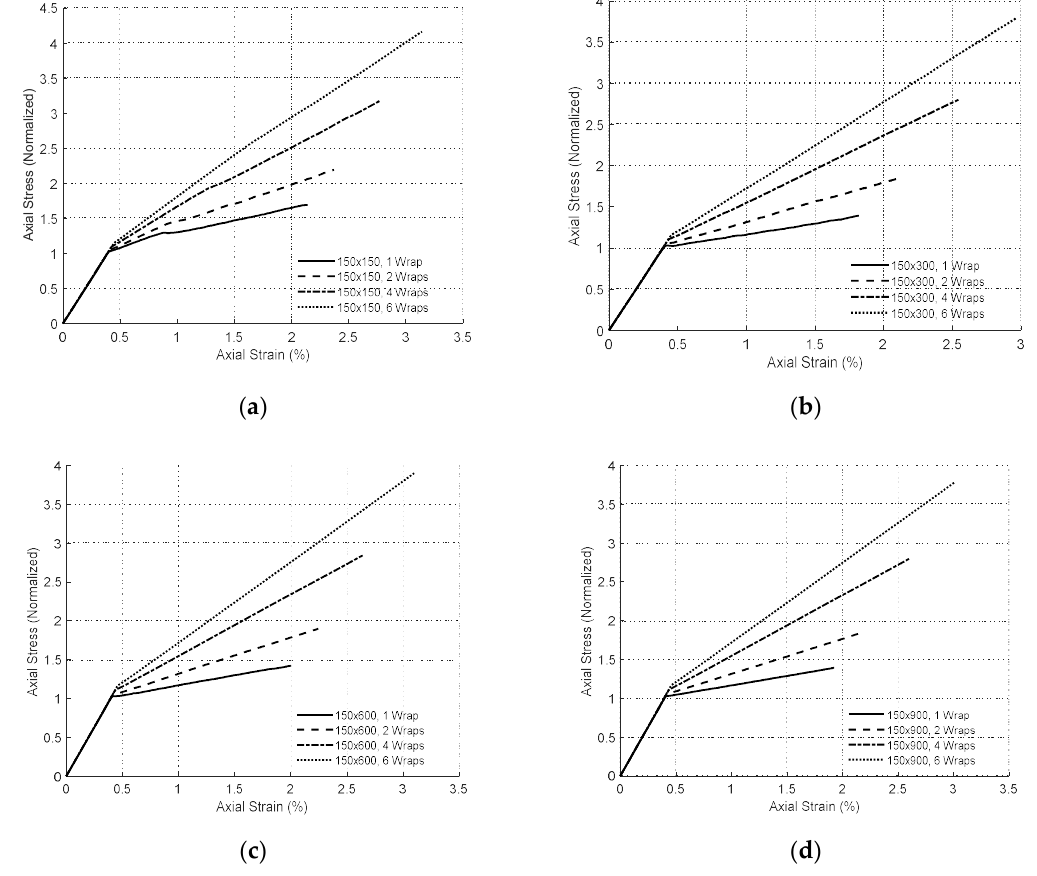
Figure 4. Effect of the number of wraps on the axial stress–axial strain response of concrete cylinders with varying slenderness (H / D): ( a ) H / D = 1, ( b ) H / D = 2, ( c ) H / D = 4, and ( d ) H / D = 6.